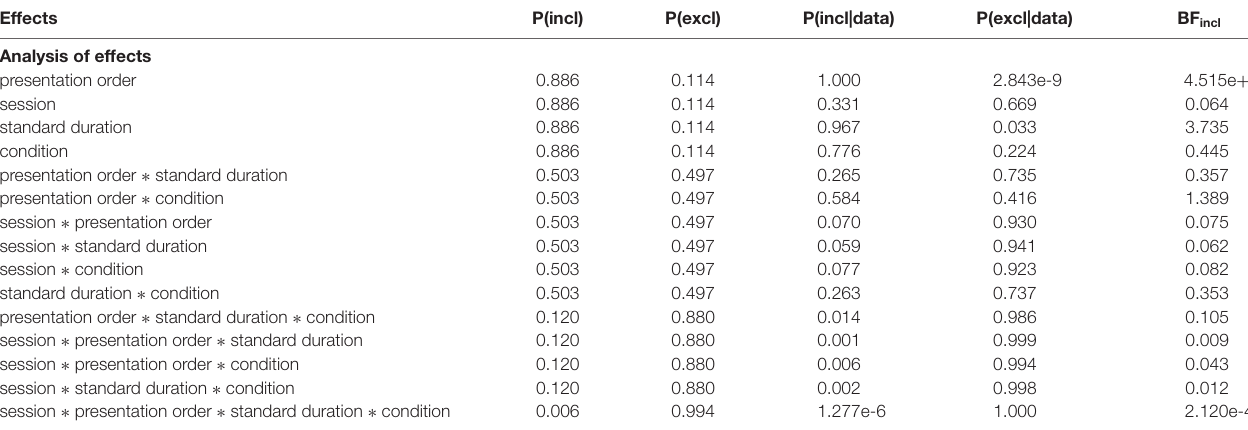
TABLE 2 | Bayes factors for inclusion calculated based on Bayesian model averaging for Weber fractions of Experiment 1.